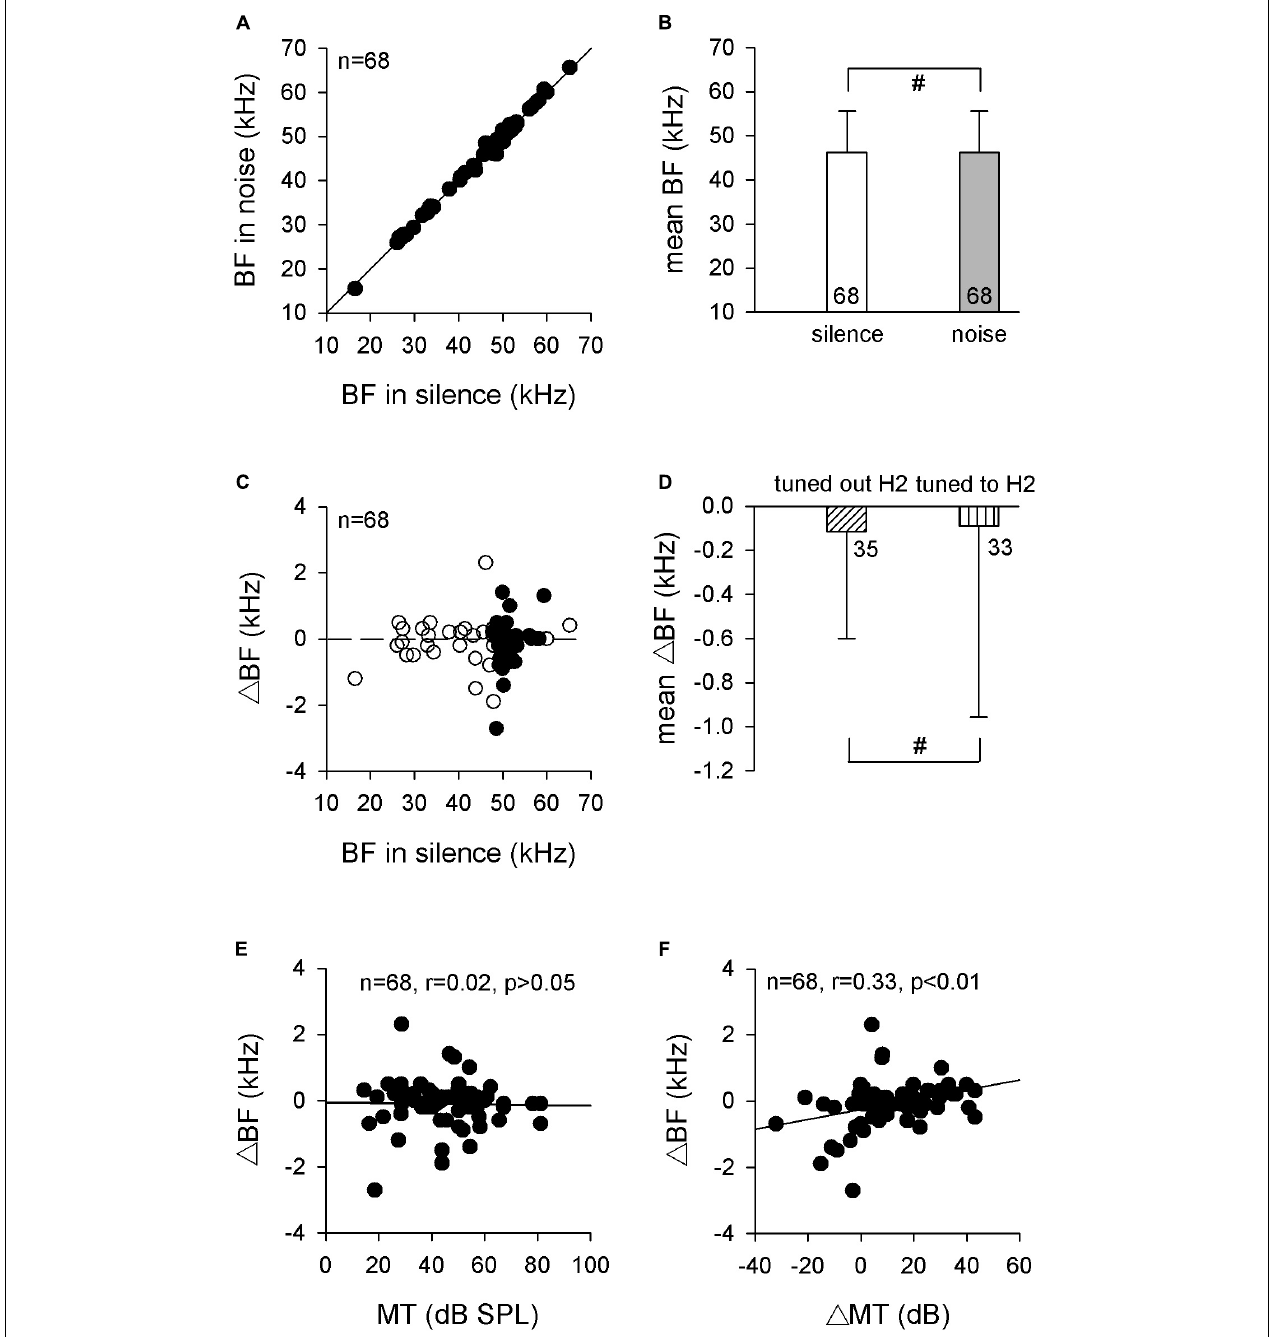
FIGURE 3 | The BFs of auditory midbrain neurons in silence and noise conditions. (A) The distribution of BF in noise compared with BF in silence. The solid line is the line of equality. (B) Comparison of the mean BF in silence and noise conditions. (C) The distribution of (cid:49) BF against BF in the silence condition. The horizontal dashed line is the zero line. Filled circle, neurons tuned to H2; unfilled circle, neurons tuned out H2. (D) Comparison of the mean (cid:49) BFs between neurons that tuned out H2 and neurons that tuned to H2. (E) The distribution of (cid:49) BF against MT. Linear-regression analysis showed no significant correlation. (F) The distribution of (cid:49) BF against (cid:49) MT. Linear-regression analysis showed a significant positive correlation. BF, best frequency. H2, the second harmonic. MT, minimal threshold. # p >